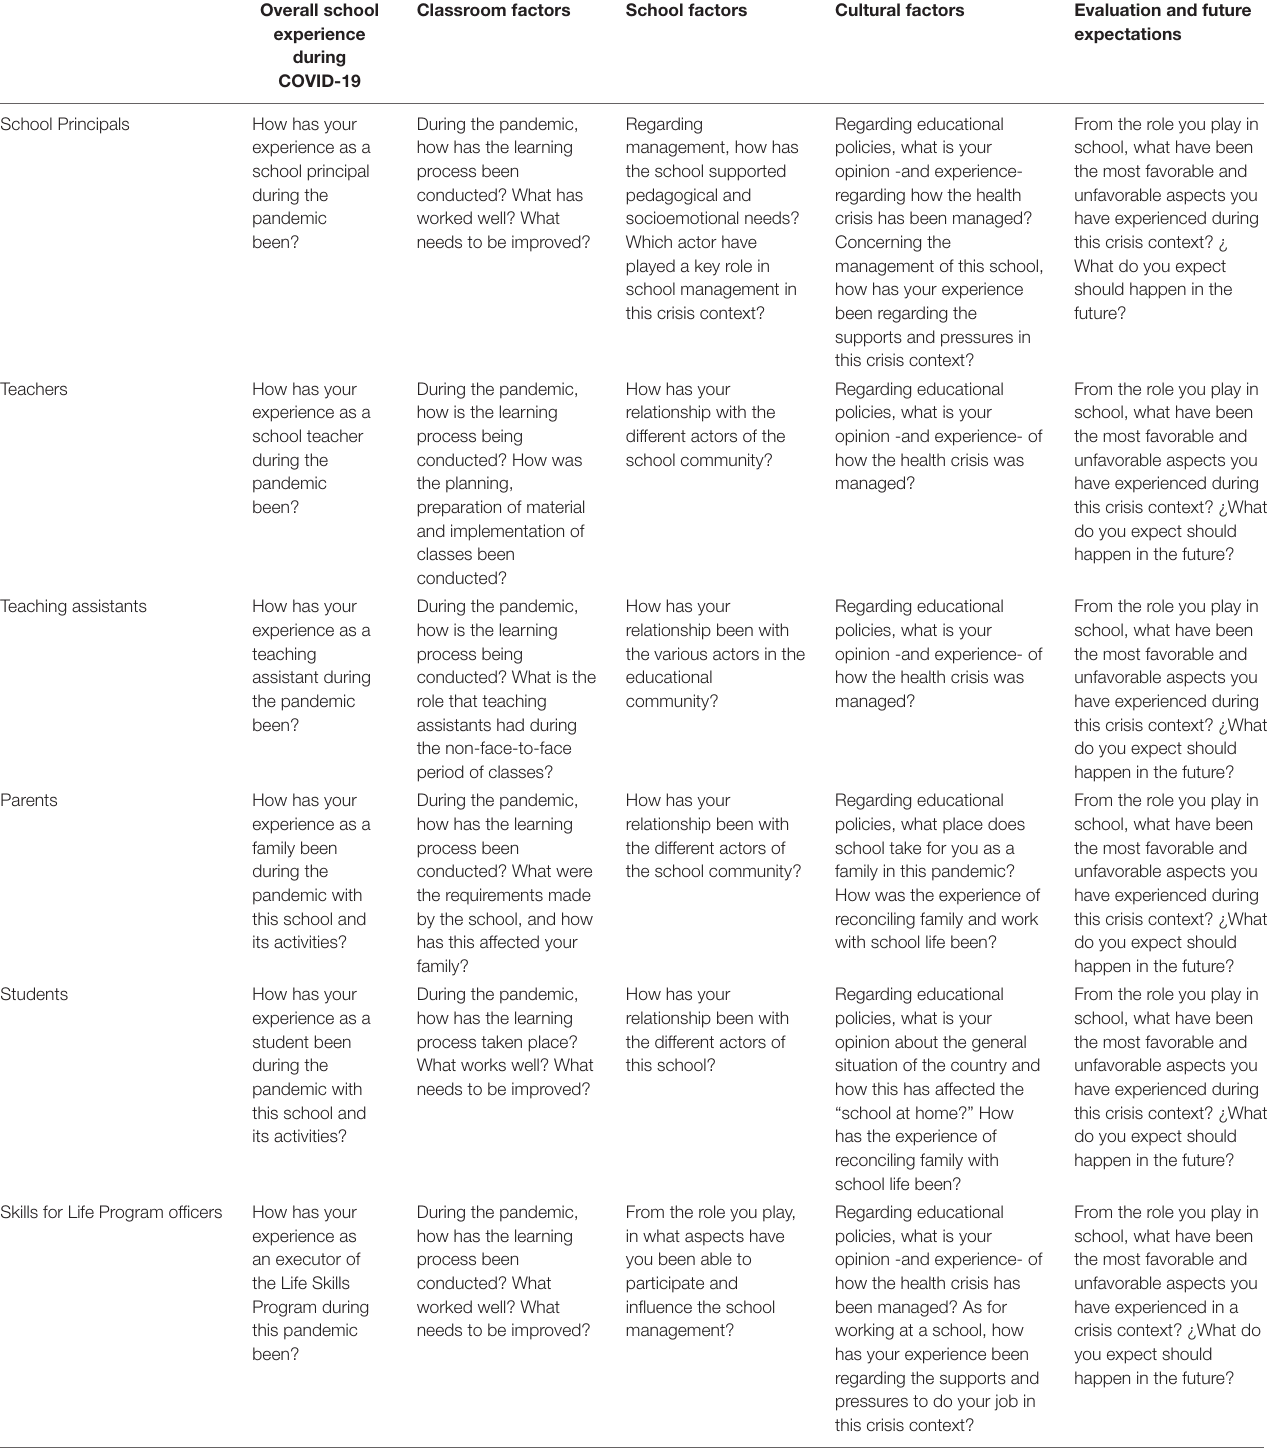
TABLE 2 | General interview scripts per actor with sample